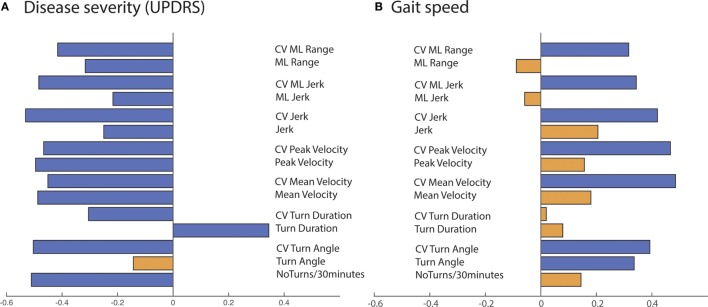
Summary of Pearson’s correlations of disease severity (A) and gait speed (B) with quantity/quality of turning over 72 h across all the Parkinson’s disease participants. Blue bar: p-value < 0.05, orange bar: p-value > 0.05.